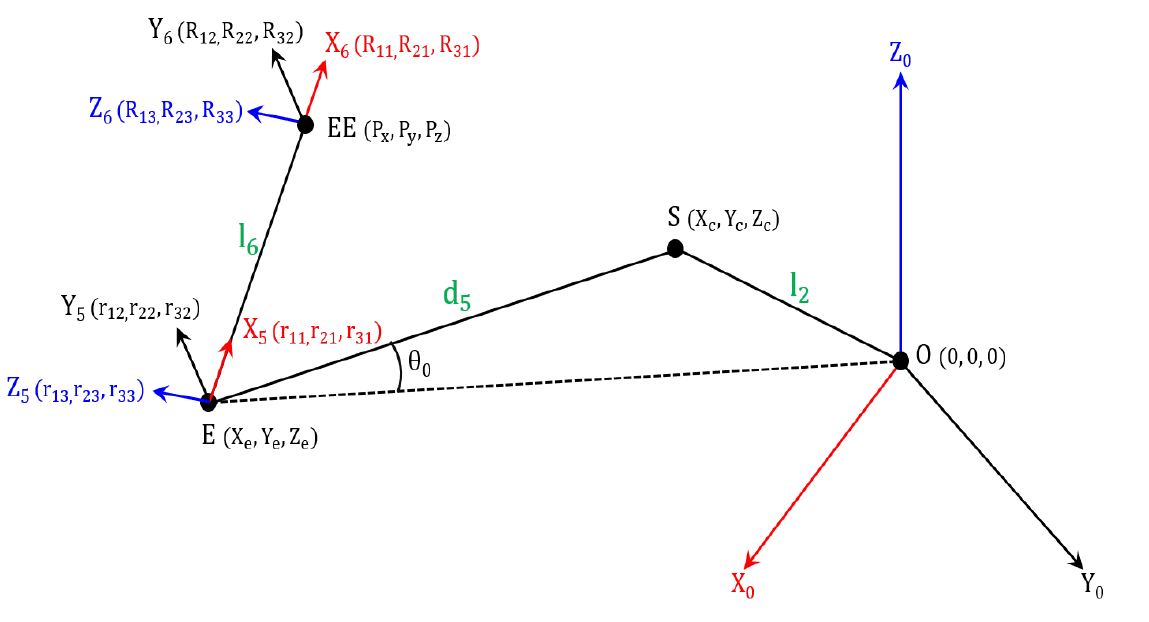
Figure 4. Position vector and direction vector of points E and EE.